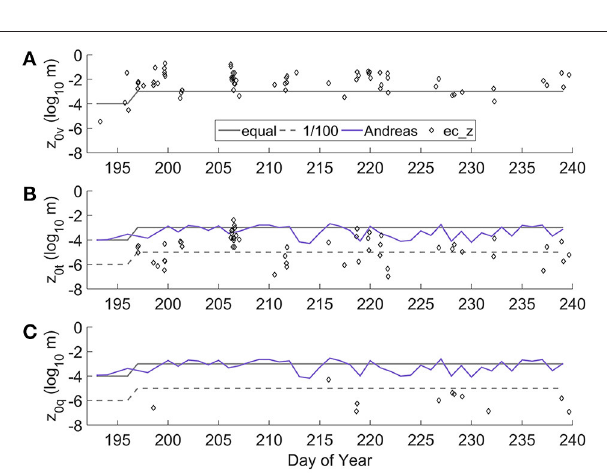
FIGURE 6 | Thirty minute EC-derived roughness length values for (A) momentum, (B) temperature, and (C) water vapor, compared with commonly assumed roughness length schemes from the literature. For the assumed schemes, z 0 v is 10 − 3 m for ice, and 10 − 4 m for snow (surface of the turbulence footprint area transitioned from snow to ice on DOY